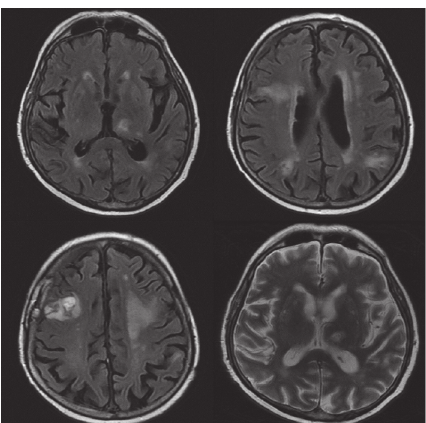
Figure 5: MRI after completion of rituximab and whole brain radiation (day 97). Rituximab started on day 63; cranial XRT started on day 70. Abnormal parenchymal enhancement in both cerebral hemispheres that have decreased in size. Increased hemorrhage in bilateral frontal and parietal lobe lesions. In the right frontal lobe there is a 15 mm rim-enhancing fluid collection. The edema surrounding most of the lesions has decreased in size. The left cerebellar lesion has decreased from 5 mm to 2 mm.